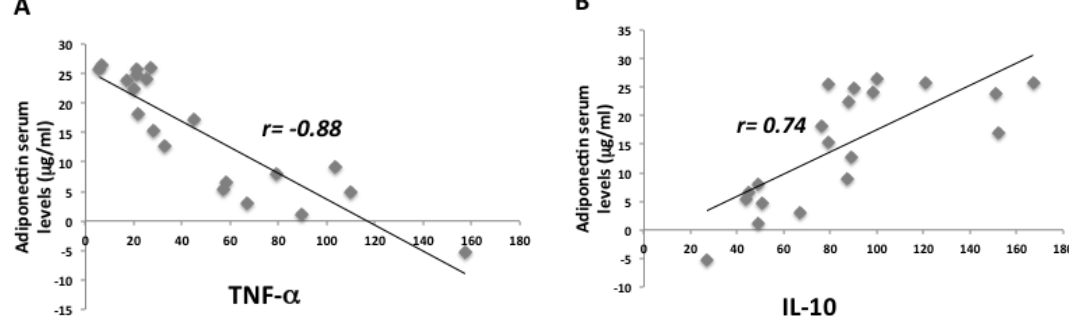
Figure 3. Adiponectin correlated to TNF- and IL-10 serum levels in our participants before and after diet. There was a negative correlation between TNF-α and adiponectin serum levels ( A ). On the contrary, there was a positive correlation between adiponectin and IL-10 ( B ).